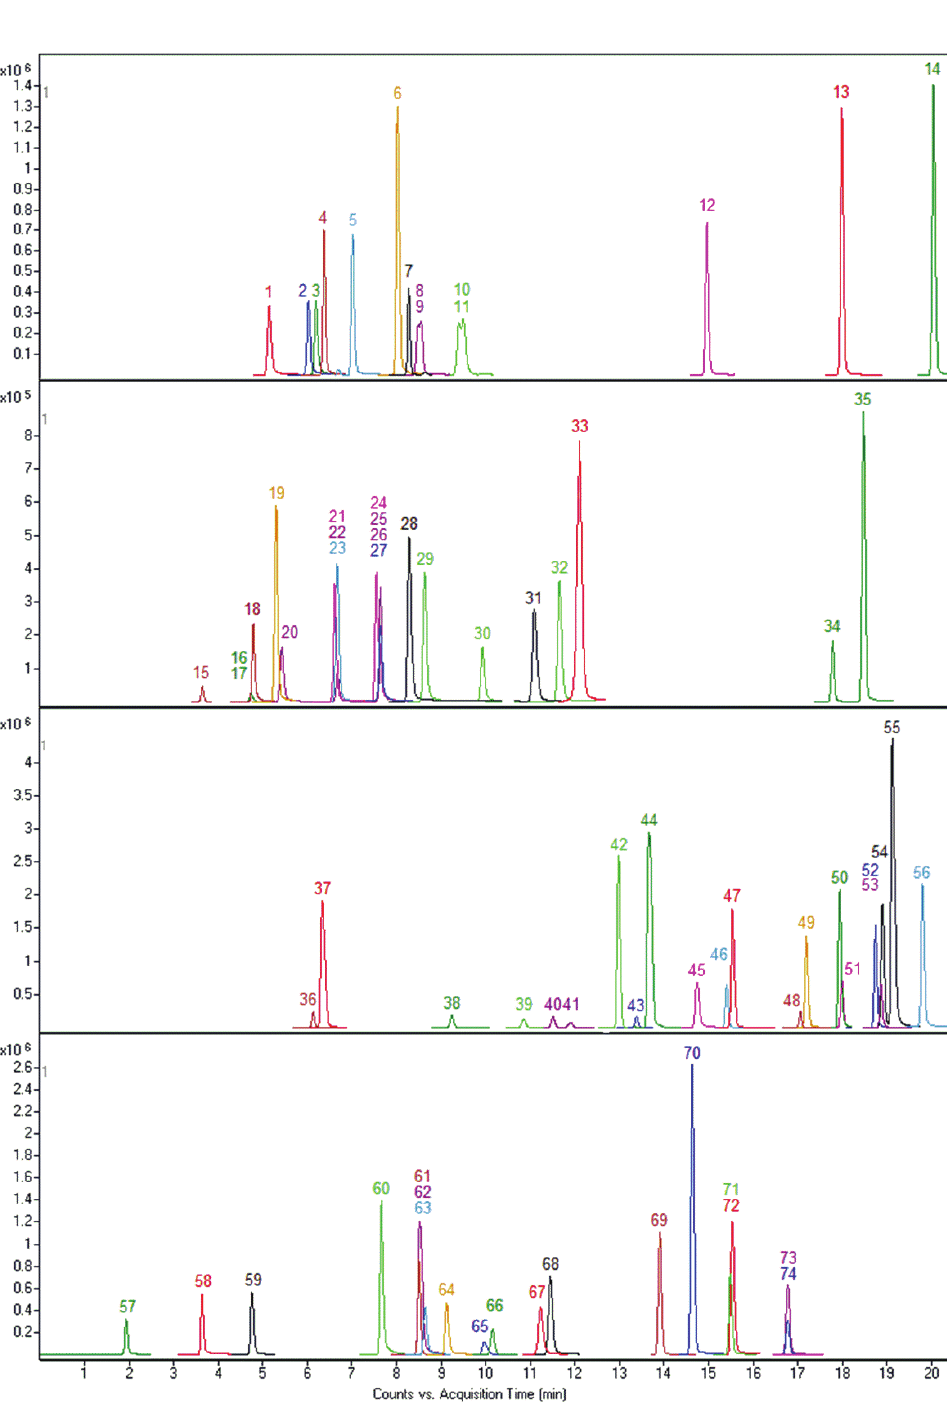
Figure 1. Chromatograms for the quantifier MRM transitions of phenethylamine, synthetic cathi- nones, fentanyl analogues and unclassified compounds, with a retention time within 0–20 min at 5 ng/mL. 1. MDEA; 2. amphetamine; 3. 4-FA; 4. methamphetamine; 5. MDMA; 6. 2C-N; 7. 5-APB; 8. 6-APB; 9. 5-MAPB; 10. 6-MAPB; 11. MDA; 12. 2C-E 13. 25H-NBOMe; 14. 25D-NBOMe; 15. methcathinone; 16. 2F-methcathinone; 17. 4F-methcathinone; 18. dimethylcathinone; 19. methylone; 20. ethcathinone; 21. ethylone; 22. methedrone; 23. buphedrone; 24. butylone; 25. 3-MMC; 26. Mephedrone; 27. eutylone; 28. 4-methyl-ethcathinone; 29. pentedrone; 30. pentylone; 31. 3,4- DMMC; 32. N-ethylpentylone; 33. MDPV; 34. 1-naphyrone; 35. naphyrone; 36. MeOAc-norfentanyl; 37. acetyl-norfentanyl; 38. norfentanyl; 39. furanyl-norfentanyl; 40. ( ± )-cis-3-met-norfentanyl; 41. ( ± )-trans-3-met-norfentanyl; 42. MeOAc-fentanyl; 43. butyryl-norfentanyl; 44. AP-237; 45. 2-methyl-AP-